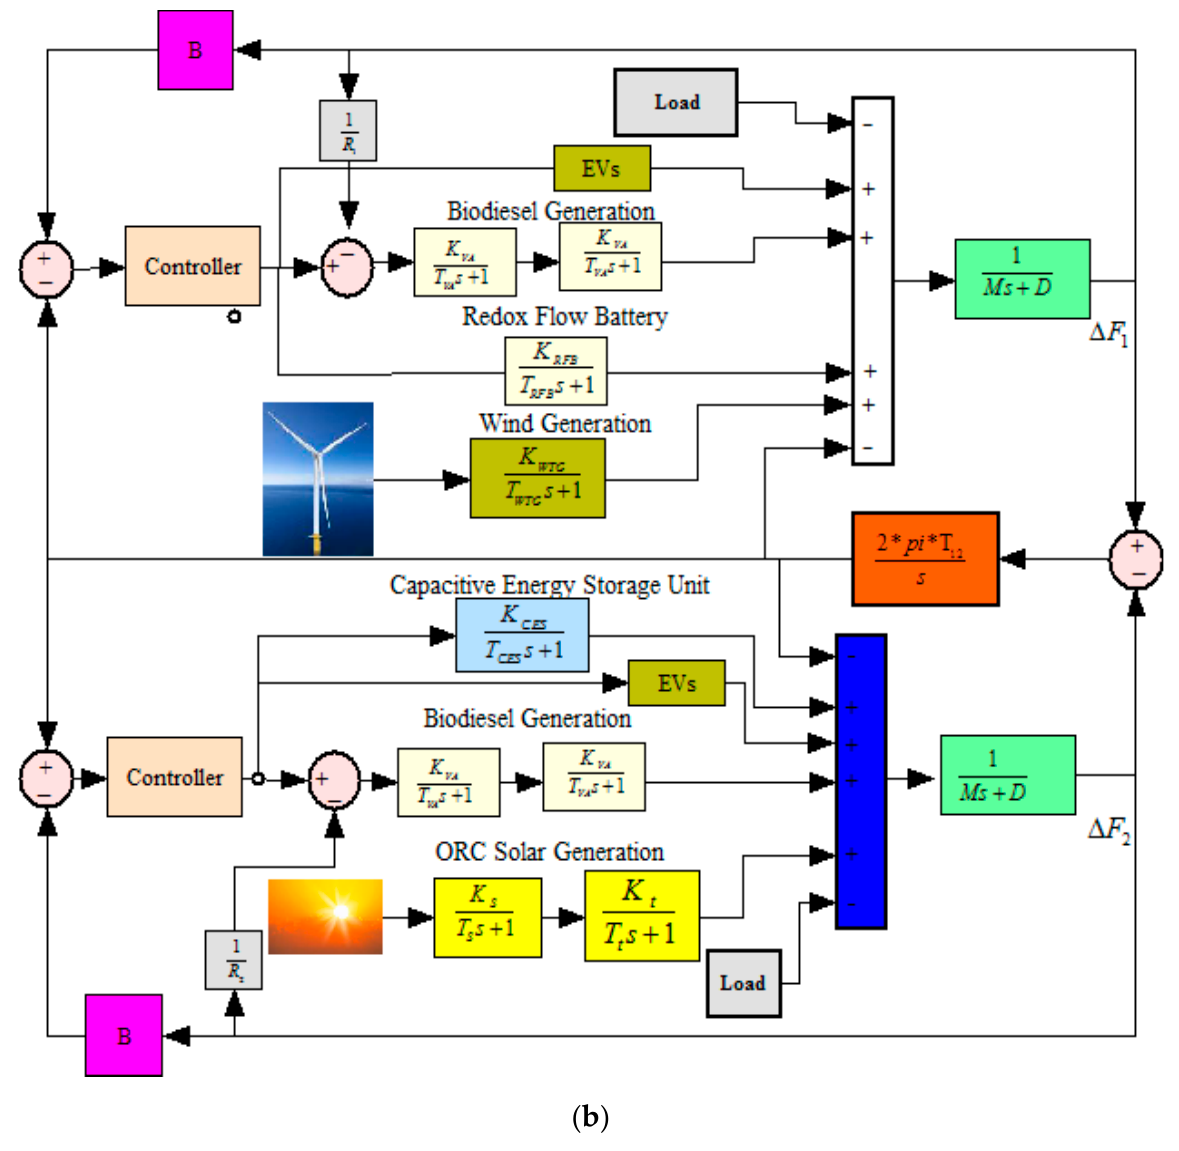
Figure 1. The proposed microgrid ( a ) schematic and ( b ) transfer function model.